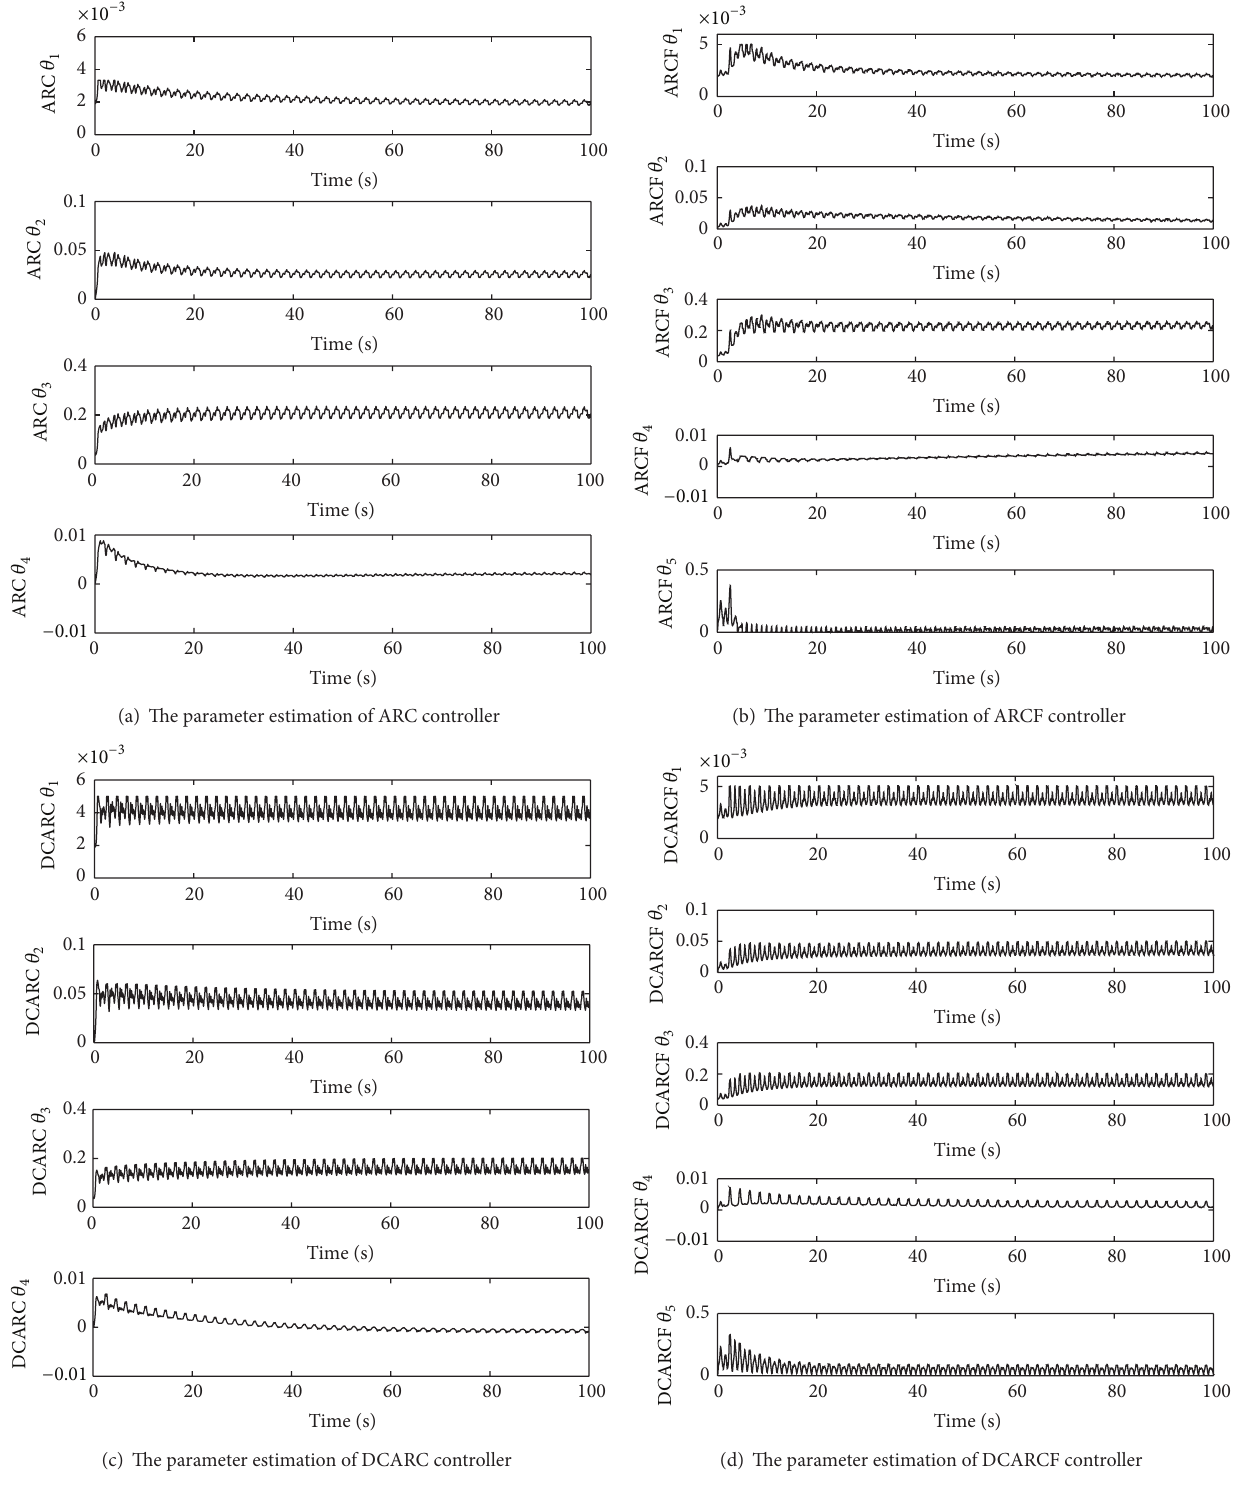
Figure 6: Parameter estimations of five controllers in normal